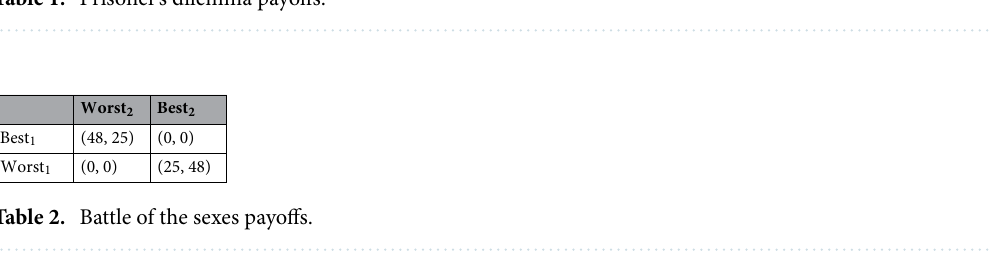
Table 1. Prisoner’s dilemma payoffs.